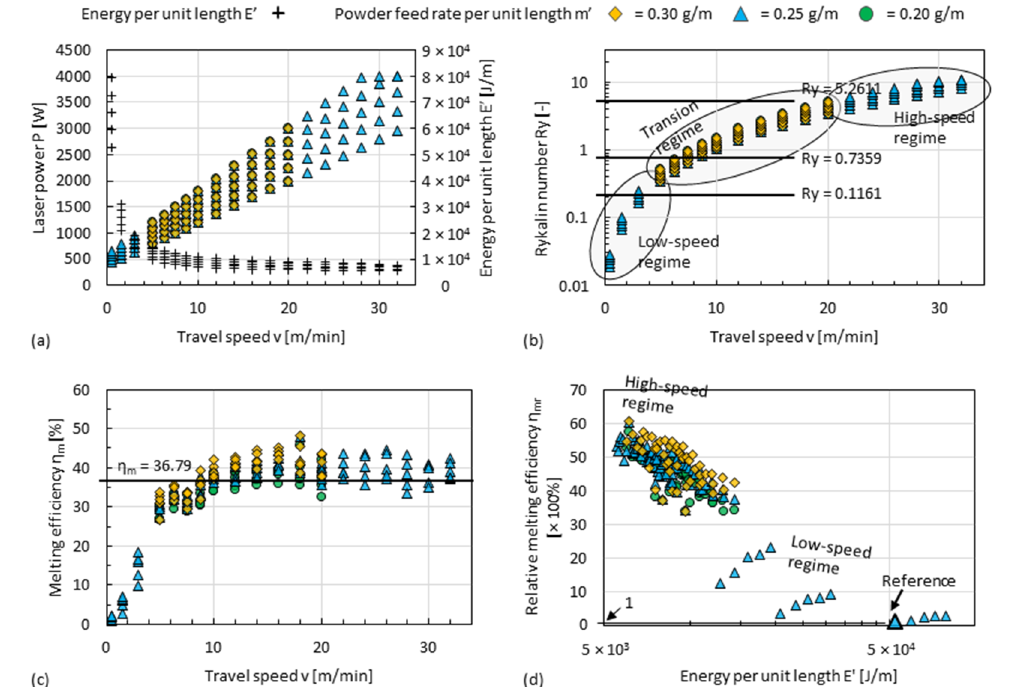
Figure 19. ( a ) Rearranged display of the parameter sets shown in Figure 6a,c and supplementary data of travel speed v = 0.5, 1.5 and 3 m/min, and the plot graph of the correspondingly calculated ( b ) Rykalin number Ry against travel speed v , ( c ) the melting efficiency η m against the travel speed v , and ( d ) relative melting efficiency η mr against energy per unit length E’ . Material properties of EN AW-5083 that thermal diffusivity a = 5.03 × 10 −5 W∙m 2 /J, thermal conductivity k = 120 W/(m∙K), melting temperature T l = 638 °C, density ρ = 2650 kg/m 3 and c p = 900 J/kg, and of EN AW-5251 that absorption rate α = 0.24, and room temperature T 0 = 20 °C are considered for the calculation.